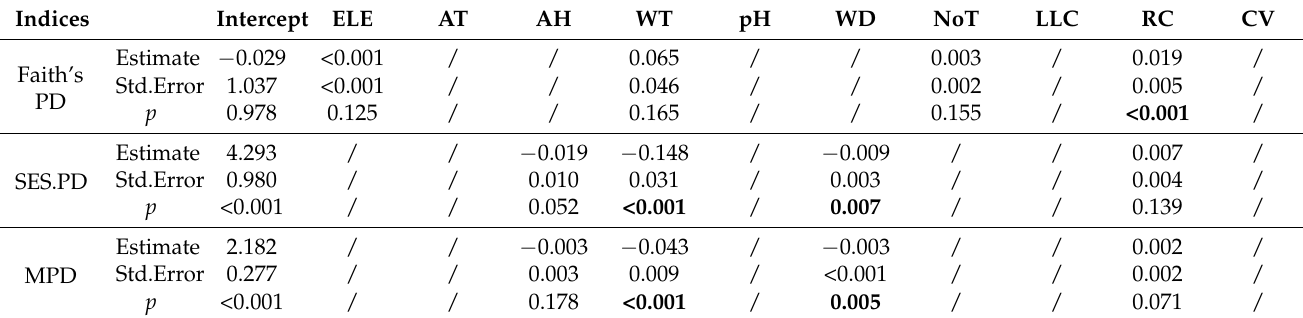
Table 1. The best-fitted models selected by the generalized linear models (GLMs) for phylogenetic structure indices. Significant p values are in bold. Details of the abbreviations are as follows: